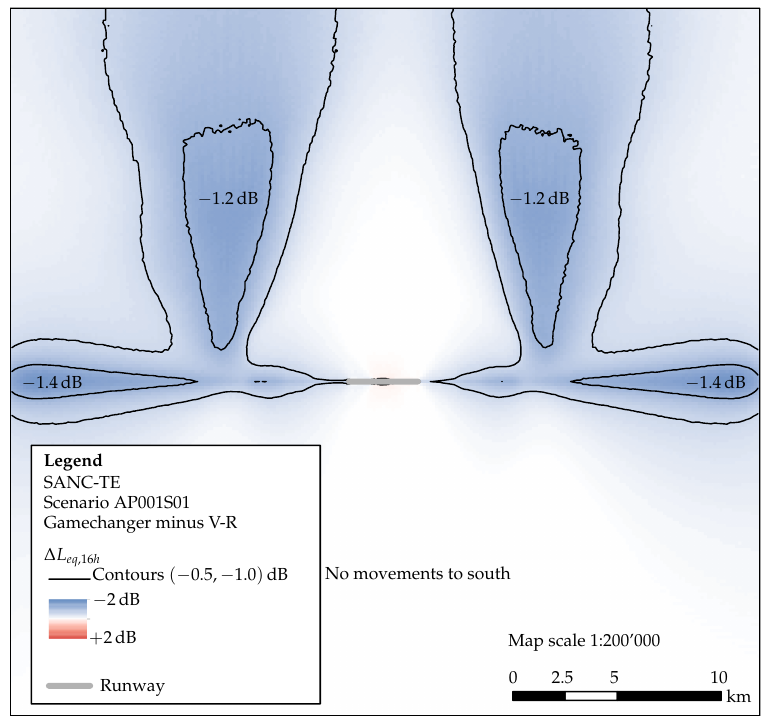
Figure 18. Level differences of L eq ,16 h between variant “gamechanger” vs.